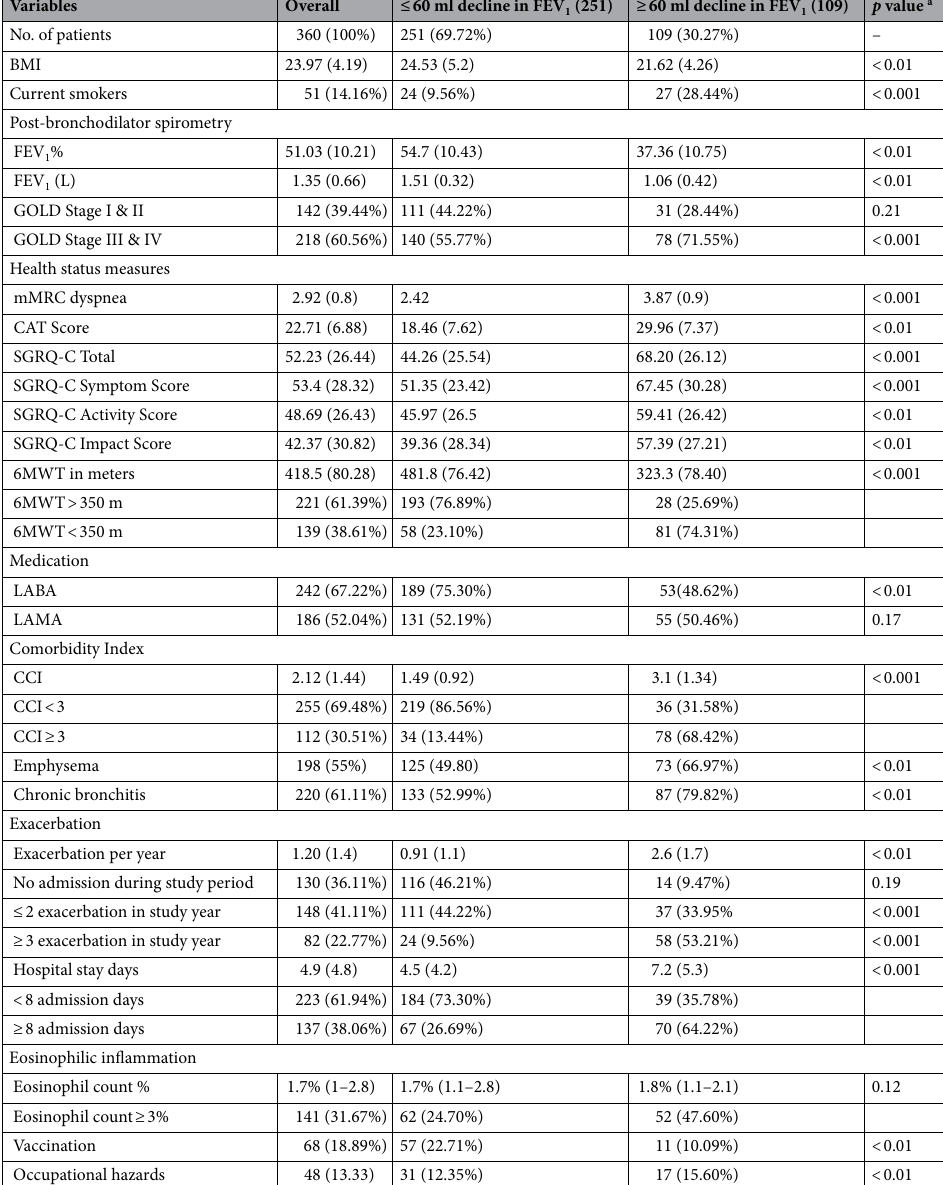
Table 2. Demographic and clinical data of COPD patients included in the study after one year follow-up. Data are presented as n (%) and mean (SD) unless otherwise stated. a The difference was assessed among groups stratified according to decline in FEV1. BMI, body mass index; COPD, Chronic Obstructive Pulmonary Disease; CAT, COPD assessment test; CCI, Charlson comorbidity Index; FEV 1 , forced expiratory volume in 1 second; FVC, forced vital capacity; FEV 1 %, percentage predicted FEV 1 ; GOLD, global initiative for Chronic Obstructive Lung Disease; GOLD Stage I (FEV1 ≥ 80% predicted); GOLD stage II (50% ≤ FEV1 <